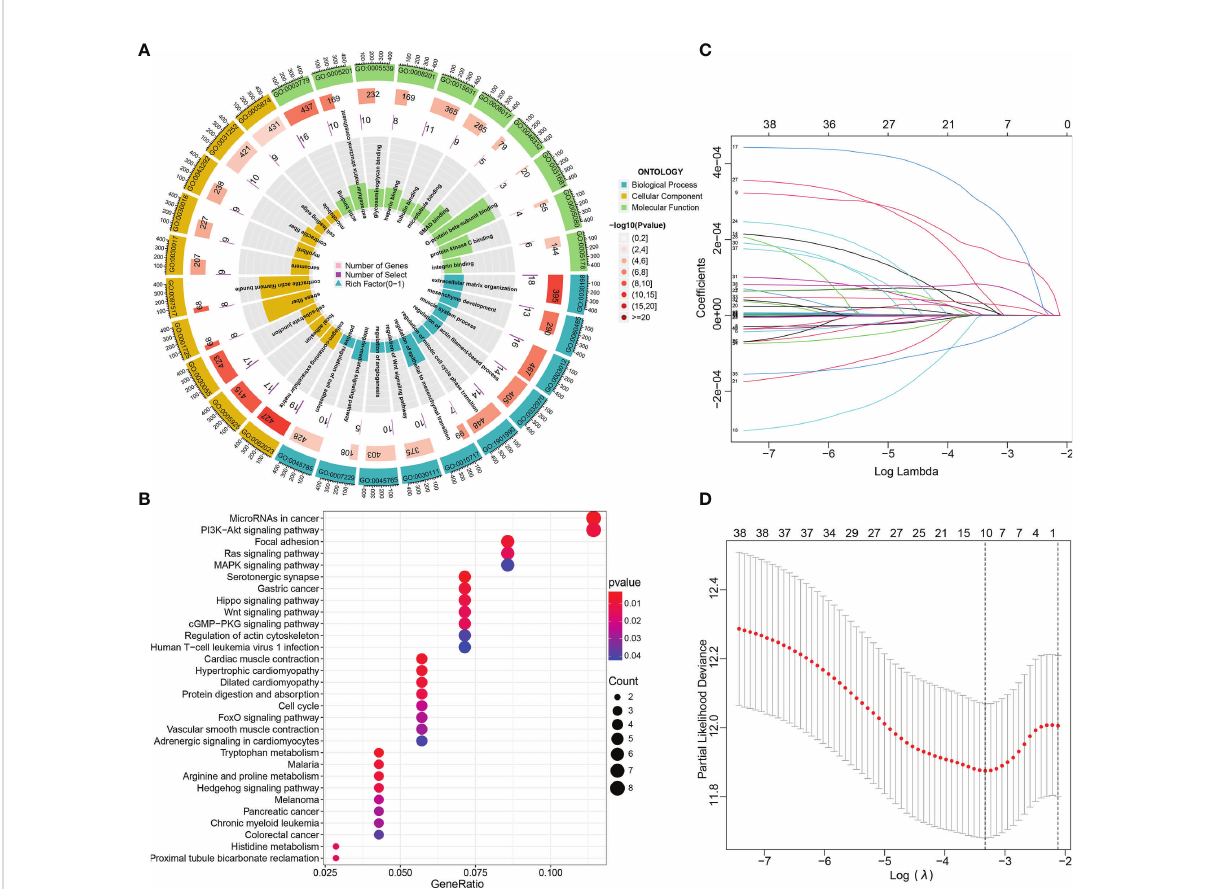
FIGURE 3 Functional enrichment and Lasso-penalized Cox regression analyses of these DE-mRNAs in the ceRNA network. (A, B) The GO function (BP, CC and MF) and KEGG pathway annotation analyses of DE-mRNAs in the ceRNA network. (C, D) Lasso regression analysis selected prognosis – related DE-mRNAs in the ceRNA network. ceRNA, competing endogenous RNA; BP, biological process; MF, molecular function; CC, cellular components; DE-, differentially